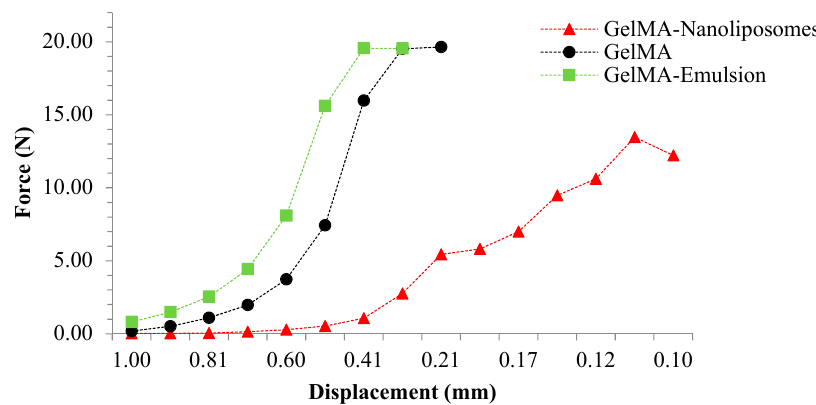
Figure 6. Typical force–displacement curves of GelMA hydrogels: pure GelMA ( ) and Functionalized GelMA ( (cid:78) : GelMA-Nanoliposomes and (cid:4) : GelMA-Emulsion).